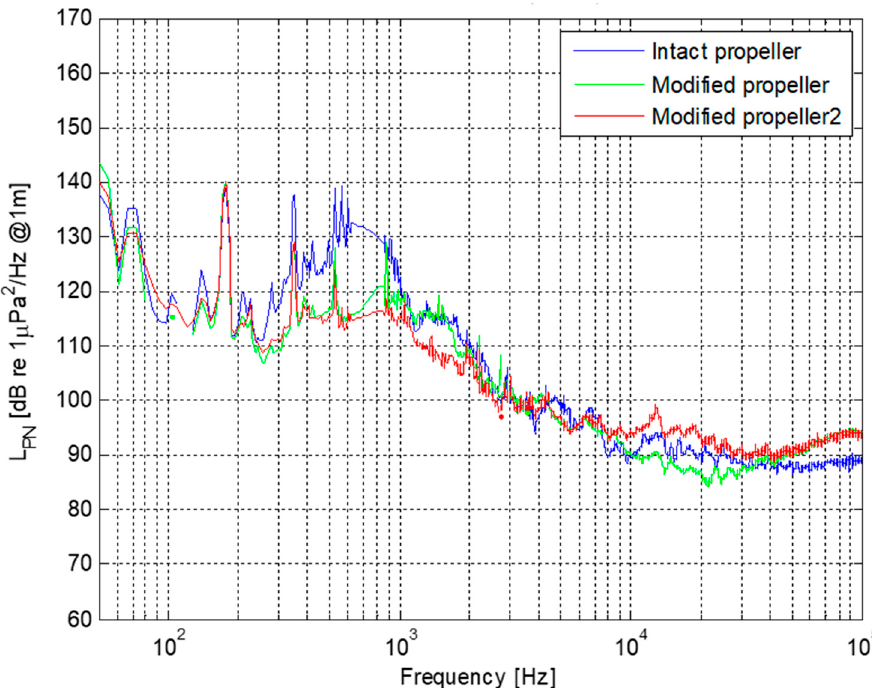
Figure 17. Comparison between Intact, Modified propeller and Modified Propeller-2 net noise levels at 1 m (narrowband), condition V2, hydrophone H3.